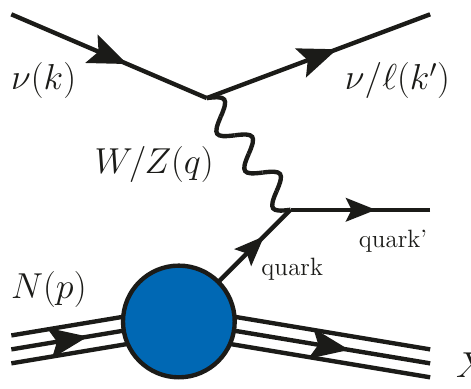
Figure 1 . Diagram for deep-inelastic neutrino-nucleon scattering. The process proceeds through the exchange of an electroweak gauge boson either neutral ( Z ) or charged ( W (cid:6)